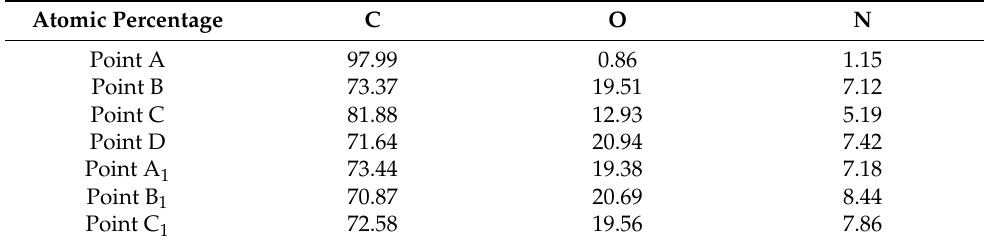
Table 8. The atomic percentage in the designated area in Figure 7 before and after cleaning.